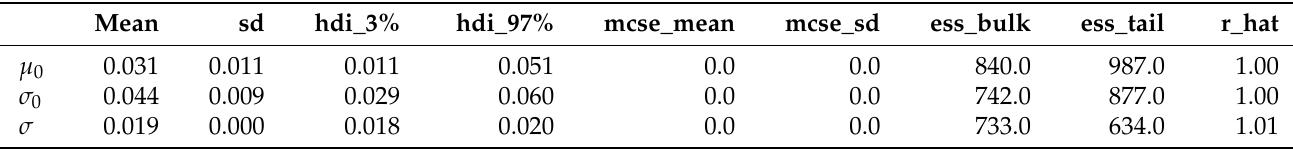
Table 3. Hyper-prior parameters of the voltage spline model are also efficiently estimated but with more difficulty. They get very thin distributions centered in the neighbourhood of zero; however, all of them are positive. Standard error of the voltage measurement is estimated at 0.02 kV which is consistent with simulations. Probabilistic computation is efficient, as Monte Carlo standard error (MCSE) is vanishingly small. Effective sample size of both bulk of distribution and its tails is on the level between 15% and 25% (total number of samples is 4000), which is a reasonable result. Potential scale reduction factor ˆ R is reasonably close to 1, indicating good mixing of Markov chains.